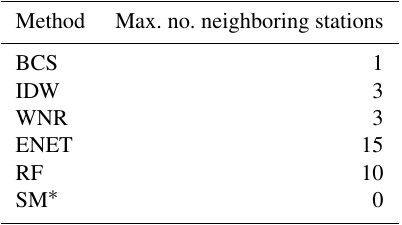
Table 1. Selected number of neighboring stations for each method.